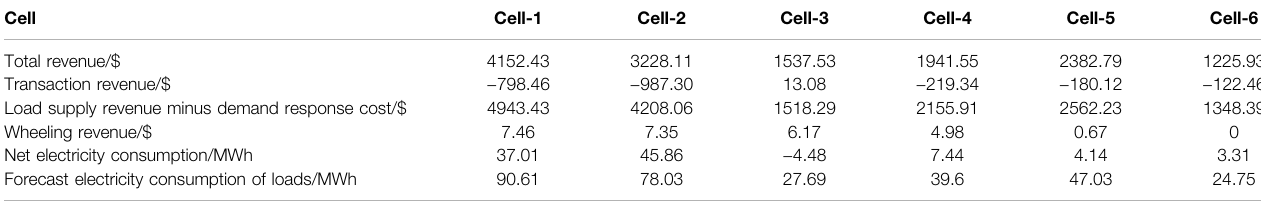
TABLE 1 | Results of distributed economic dispatch.